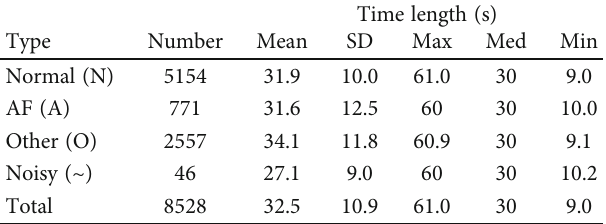
Figure 1: Data set composition diagram. Table 1: Data table for the training